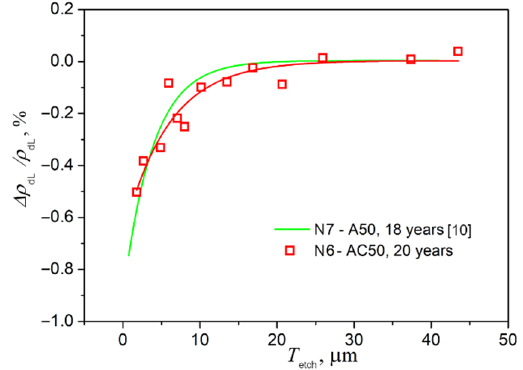
Figure 7. Dependence of the value of the density defect in the near-surface layer of samples N7 (A50, service life of 18 years) [10] and N6 (AC50, service life of 20 years). Thus, within the statistical spread of the experimental values Δ ρ dL / ρ dL , both types of wires show the presence of two characteristic values of the thickness of near ‐ surface defect layers (NSDLs), in which there appears to be a noticeable decrease in density compared to the bulk of the wires. In narrow near ‐ surface layers less than ~10 μ m thick, the density is the lowest due to the high concentration of void defects and demonstrates the greatest changes with distance from the surface in depth, and at depths from the surface of ~10 to ~30 μ m, it weakly increases until stabilization, apparently due to the reduction in the number of defects. It is also worth noting that the absolute value of the density defect of the near ‐ surface layer in wires from cables with a steel core (AC50) is somewhat less (by ~0.1–0.2%) than for A50 wires, and, as follows from Figure 7, this difference is most noticeable in a narrow near ‐ surface layer ~5–10 μ m thick. The smaller absolute value of the NSDL ‐ density defect in AC50 wires probably reflects a smaller number of void defects in these wires due to the softening effect of the steel core. Additionally, the densitometry method was used to study the relative change in the integral density (defect Δ ρ d / ρ d of the integral density) of A50 samples in the range from 0